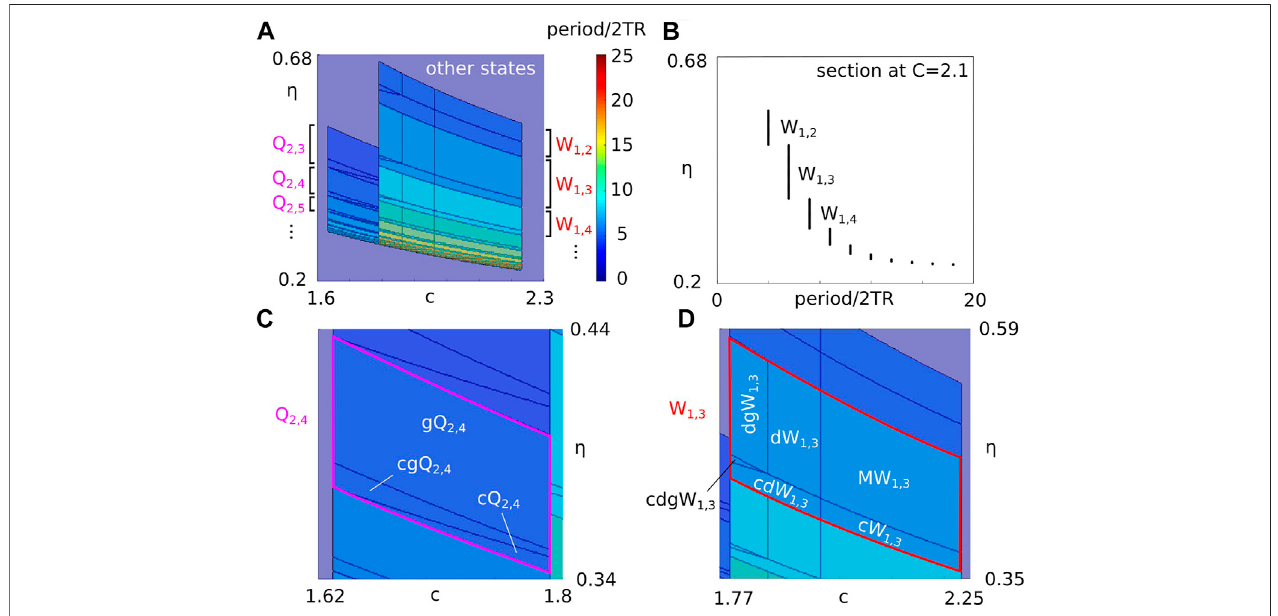
FIGURE 5 | (A) Regions of existence of Q - and W -switching states in the space of parameters ( c , η ), where colors show the states ’ period (scaled by 2 T R ). (B) Section ofpanelAat fi xed c (cid:2) 2.1showsthedependence ofthestates ’ period on η . (C) ZoomofpanelAshowingthesubdivisionofexistenceregionsforstatesingroup Q 2,4 . (D) Zoom of panel A showing the subdivision of existence regions for states in group W 1,3 . Model parameters are the same as in Figure 1F .